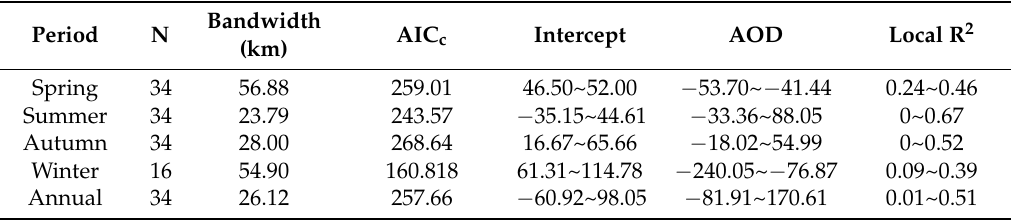
Table 3. Estimated parameters of the GWR